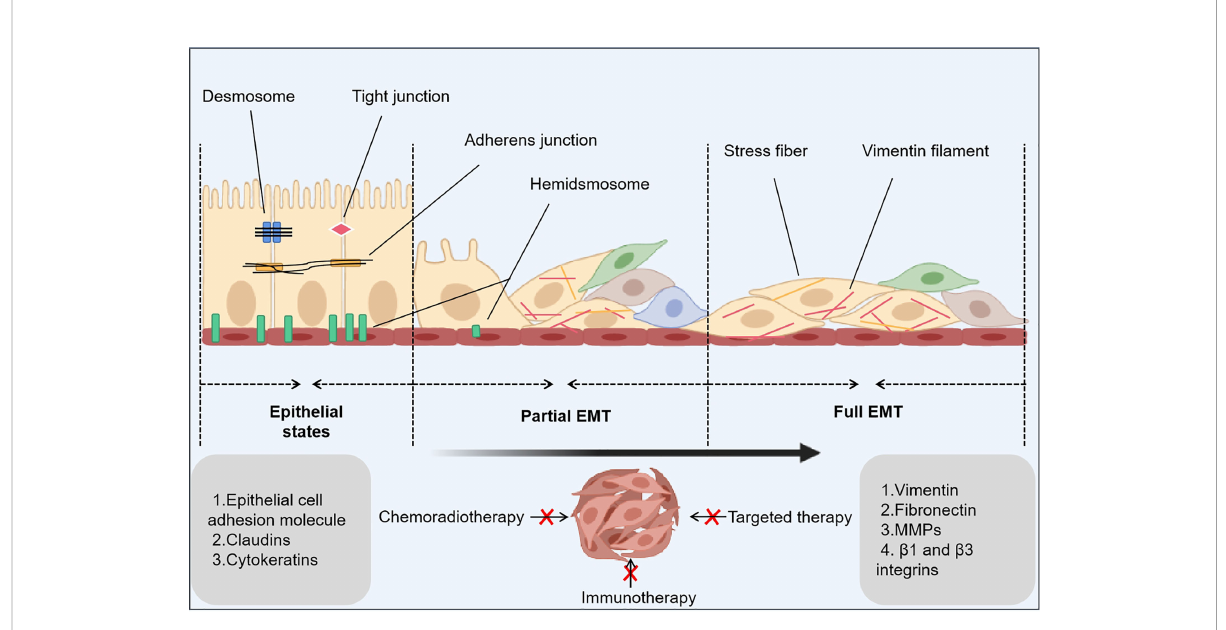
FIGURE 1 EMT-related principles underlying cancer drug resistance. The epithelial-mesenchymal transition (EMT) is a dynamic process that consists of three states: an epithelial state with epithelial phenotypes, a hybrid state with epithelial phenotypes and mesenchymal phenotypes, and a mesenchymal state with mesenchymal phenotypes. In the latter two states, a small number of cancer stem cells and drug-tolerant persister cells occur to inhibit anticancer